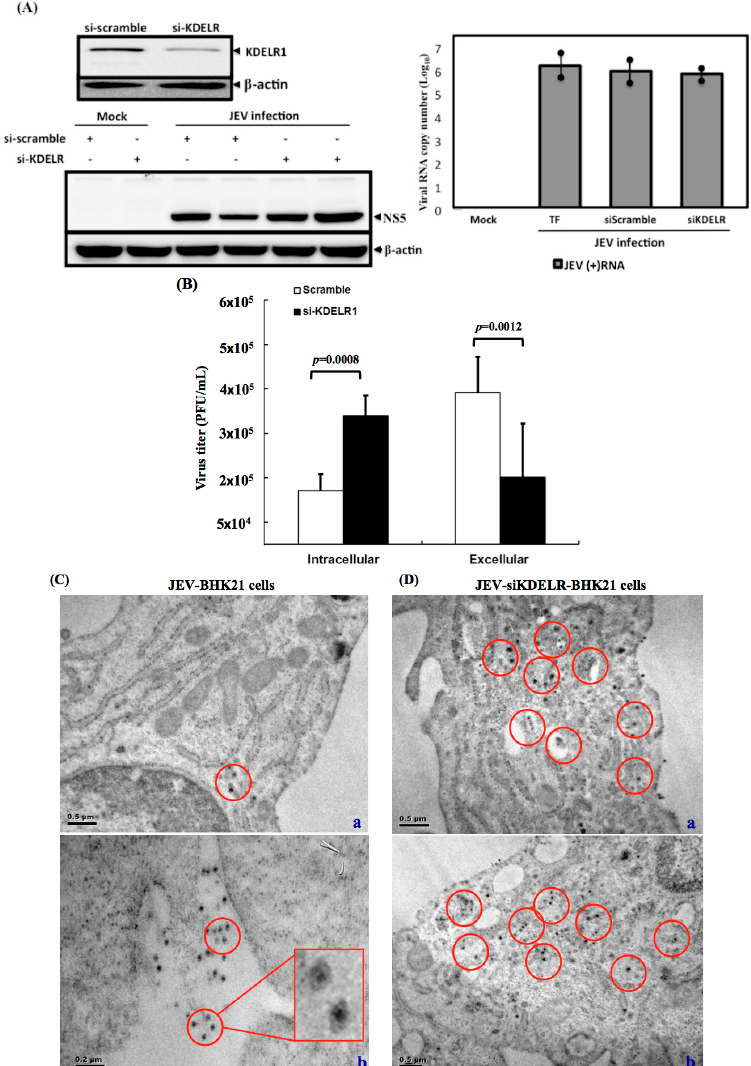
Figure 7. Knockdown of KDELR protein resulted in the reduction of extracellular viral infectivity in the BHK-21 cells. ( A ) Knockdown of KDELR protein does not affect JE viral replication. The reduced expression of KDELR protein was indicated in the siKDELR-treated cells. The production of viral protein, NS5 and accumulation of viral RNA were not affected in the anti-KDELR siRNA transfected compared to the anti-scramble siRNA transfected BHK-21 cells (TF: transfection reagent only). ( B ) The intracellular accumulated JE viral particles were detected in the siKDELR-treated cells. The anti-KDELR siRNA transfected or anti-scramble siRNA transfected BHK-21 cells were infected with JEV for 48 h. The JE virions were collected from cell lysate processing with freeze-and-thaw (intracellular) or the cultured medium (extracellular). The infectivity of JEV progeny from either intracellular or extracellular samples was performed in the plaque assay. The virus titers are shown in PFU/mL. Three independent knockdown experiments were performed. ( C,D ) Ultrastructural analysis of the JEV-infected BHK-21 cells. ( C ) The si-scramble-treated transfected BHK-21 cells were infected with JEV and harvested at 48 h for ultrastructural analysis using electron microscope; JEV electron dense particles (showed in red circle) can be observed in close proximity with the plasma membrane ( a ); in particular, many JEV electron dense particles were found outside of the plasma membrane ( b ). An enlarged photo was inserted to indicate that dense particles were JE virions; ( D ) In the siKDELR-treated cells, the JEV electron dense particles (shown in the red circles) were found in close proximity to the replication complexes ( a,b ). An representative enlarged photo of JEV electron dense particles was shown in the red box. No similar structures were seen outside of the plasma membrane in the siKDELR transfected